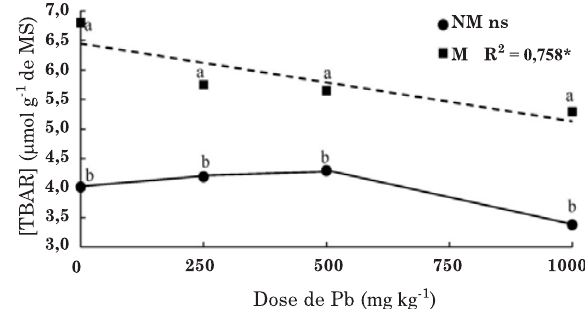
Figura 8. Concentração de substâncias reativas ao ácido tiobarbitúrico (TBARS) em folhas de plan- tas de Stizolobium aterrimum não micorrizadas (NM – linha contínua) e micorrizadas (M – linha tracejada) crescendo em solo contaminado com Pb. Letras iguais não diferem entre si pelo teste de Tukey a 5 % entre os tratamentos NM e M, dentro de cada dose de Pb. * p < 0,05; ns: regres- são não